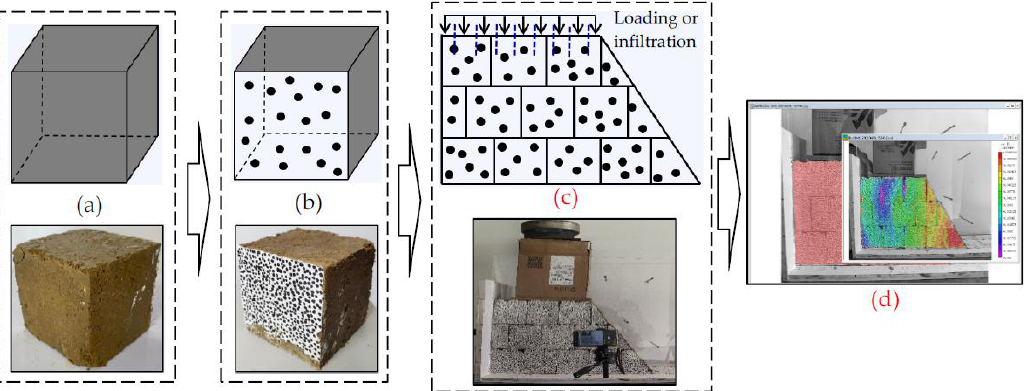
Figure 3. Model tests of expansive soil with different crack networks. ( a ) Remolded sample of expansive soil; ( b ) remolded sample with speckles; ( c ) expansive soil slope model with cracks; ( d ) strain images from VIC-2d software.